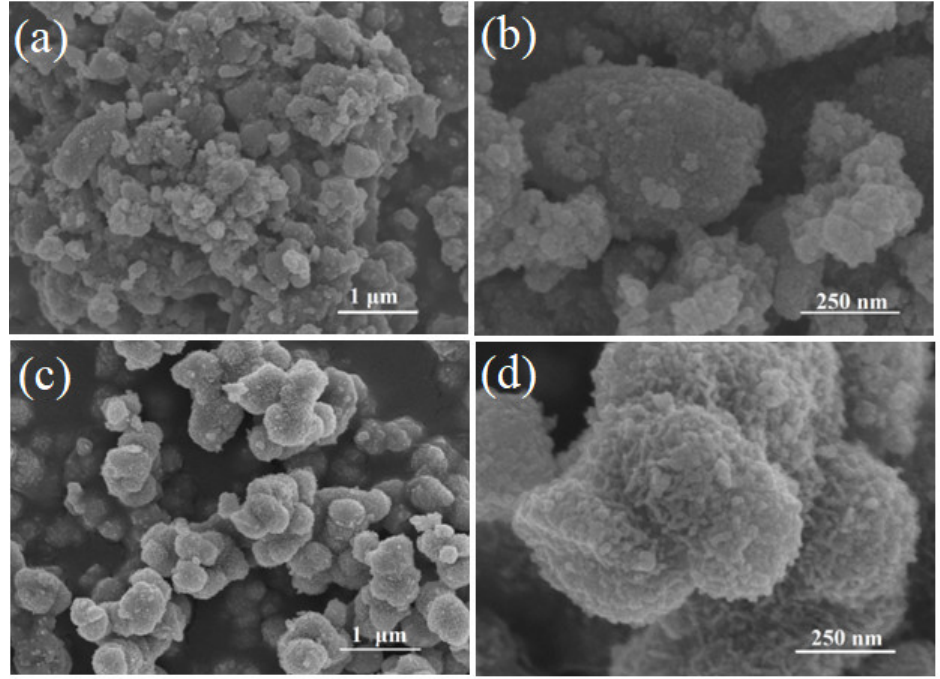
Figure 3. SEM images of MnO 2 -M ( a , b ) and MnO 2 ( c , d ).